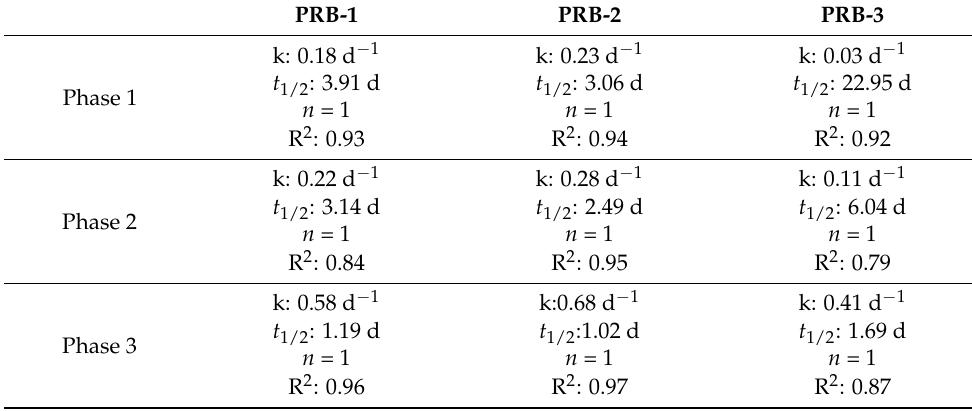
Table 6. Calculated reaction rate factors for the first-order kinetic